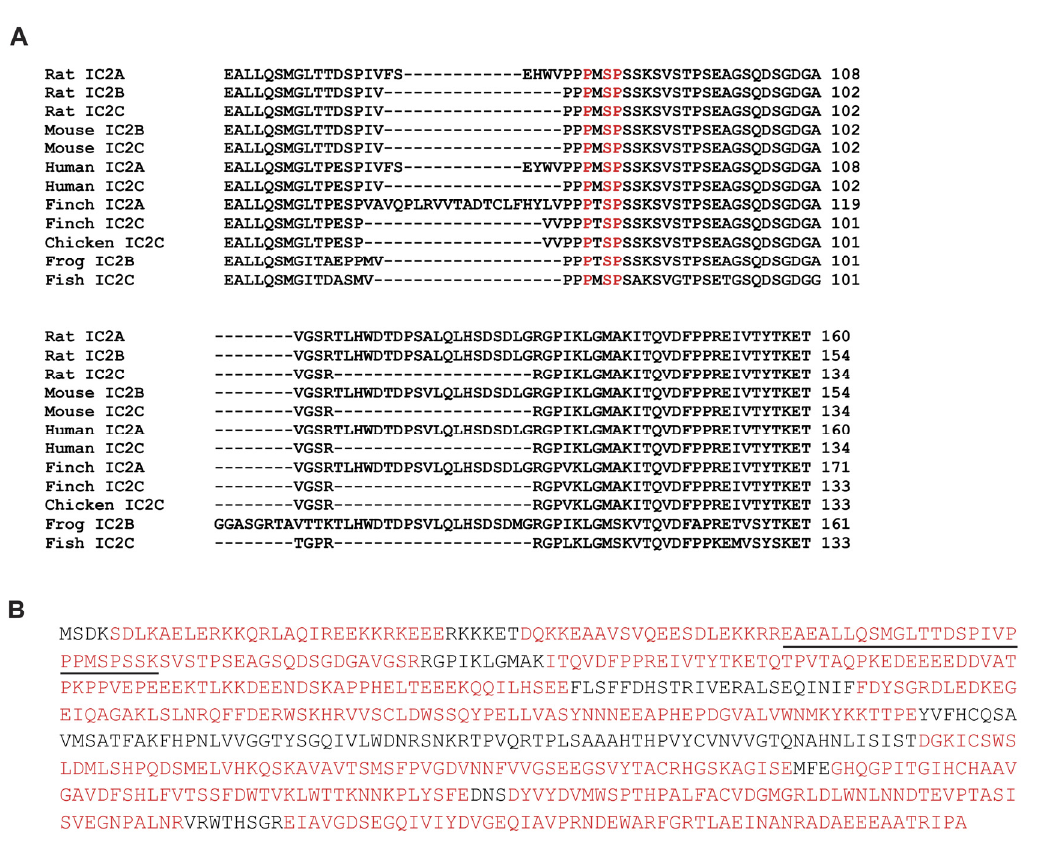
Figure 3. ( A ) Serine 81 lies within a PXSP (highlighted in red) motif conserved in vertebrates. Aligned are partial primary sequences from rat ( Rattus norvegicus ), mouse ( Mus musculus ), human ( Homo sapiens ), zebra finch ( Taeniopygia guttata ), chicken ( Gallus gallus ), Western clawed frog ( Xenopus tropicalis ) and zebrafish ( Danio rerio ); ( B ) IC-2C was purified from EGF stimulated cultures and subject to digestion with Trypsin, endoproteinase Asp-N or endoproteinase Glu-C. Residues identified by mass spectrometry are shown in red (~78% sequence coverage). The tryptic peptide containing Serine 81 is underlined; ( C ) MS/MS spectrum for the tryptic peptide containing Serine 81. The theoretical b - and y -ions are shown and those found experimentally are underlined; a double underline indicates that the doubly charged ion was also seen. These ions are also shown on the spectrum along with several brackets indicating prominent water losses. The spectrum is magnified 5X except for the y , y 92+ and b 182+ ions which are extremely intense 9 proline directed fragments; ( D ) The parent m/z for the S81 phosphorylated peptide producing a M+H + of 2863.3536 (1.1 ppm). This particular peptide was seen in four forms due to the presence of two Methionine residues. Selected ion chromatograms (inset) were used to estimate the ratio of phosphorylated S81 peptide to non-phosphorylated S81 peptide in control and EGF-stimulated samples following either Trypsin or Asp-N digestion (see Table